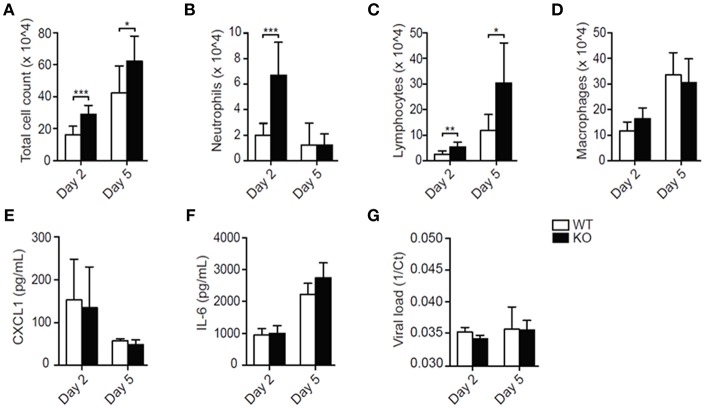
LAIR-1 regulates neutrophil and lymphocyte recruitment during RSV-A2 infection in mice. (A–G) Mice were inoculated with RSV-A2 and sacrificed on day 2 or 5. Total (A) and differential (B–D) BAL cell counts, BAL CXCL1 (E) and IL-6 (F) concentrations, and viral loads (G) were determined. Data are presented as means ± SD and represent 8 mice per group in 2 independent experiments. *p < 0.05, **p < 0.01, ***p < 0.001; unpaired Student's t-test with Welch's correction. WT, wild-type and KO, Lair1−/− on C57BL/6 background.